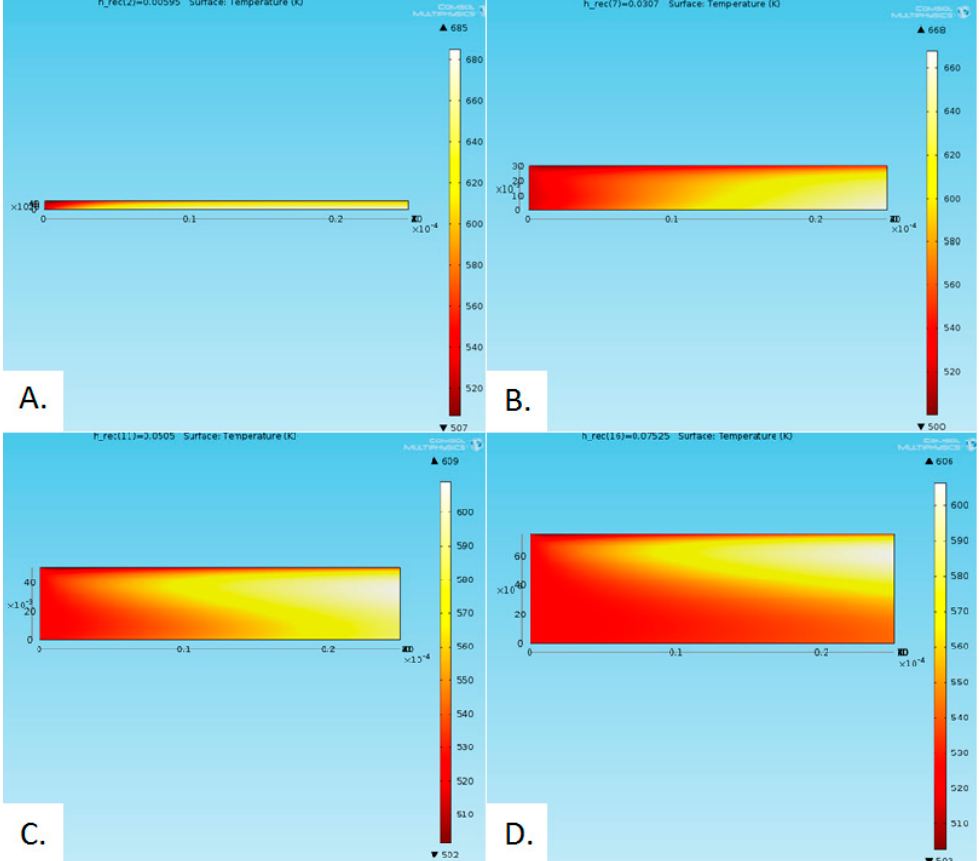
Figure 13. Temperature distribution for different receiver heights: ( A ) 0.00595 m, ( B ) 0.0307 m, ( C ) 0.0505 m and ( D ) 0.07525 m.